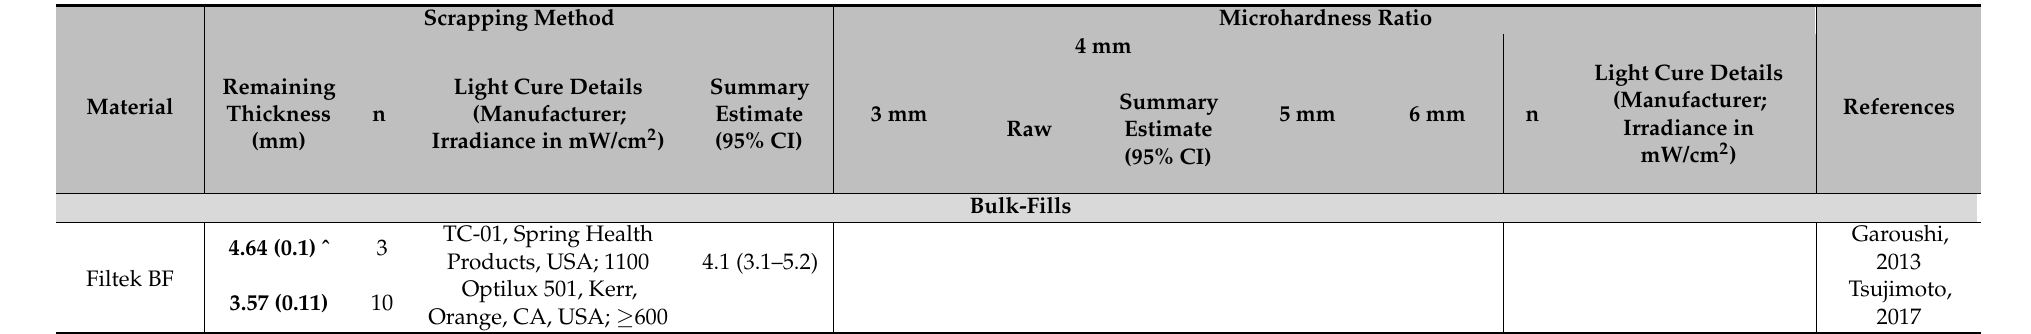
Table 6. Means and standard deviations (in parenthesis) of depth of cure and microhardness ratio data from studies utilizing 20 s light curing